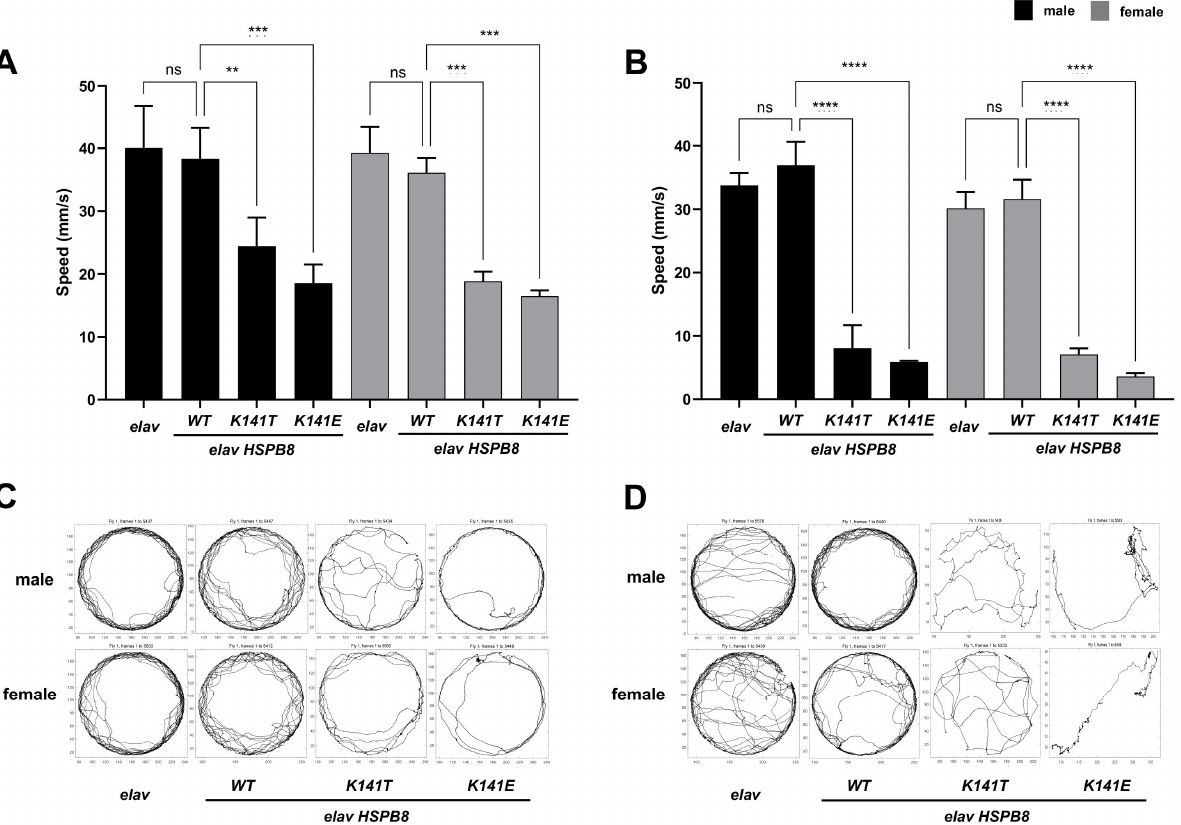
Figure 3. Expression of mutant HSPB8s in Drosophila neurons reduced motor performance. The following analyses were performed using elav , elav HSPB8 WT , elav HSPB8 K141T and elav HSPB8 K141E male and female flies: ( A , B ) Comparison of the mean walking speeds for 5- ( A ) and 15-day-old flies ( B ) ( n = 5 per group). ( C , D ) Movement trajectories of 5- ( C ) and 15-day-old flies ( D ). Significance was determined by Sidak test after one-way ANOVA (**, p < 0.01; ***, p < 0.001; ****, p < 0.0001; ns, not significant). Error bars indicate the mean ± SD.